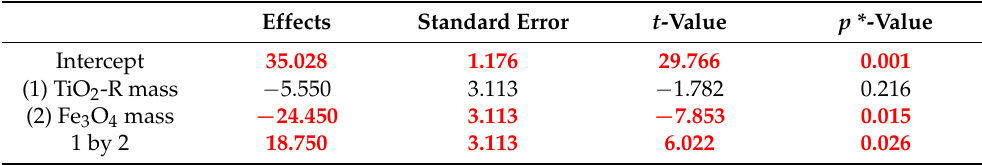
Table 3. Effects for dye degradation percentage response.